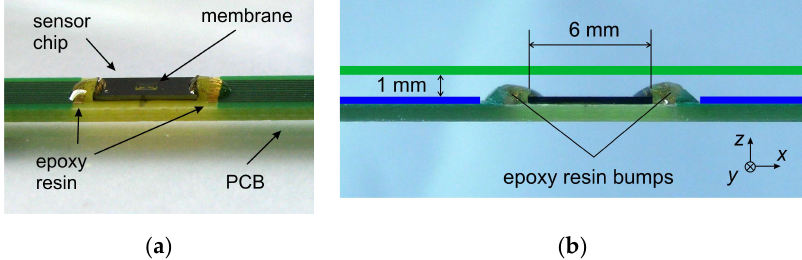
Figure 15. ( a ) Sensor chip (L × W × H: 6 × 3 × 0.35 mm³) mounted on the printed circuit board (PCB). The bonding wires are protected with epoxy resin. ( b ) Side view (orthogonal to x–z -plain). The bottom of the flow channel is indicated with the blue lines and its upper wall with the green line.